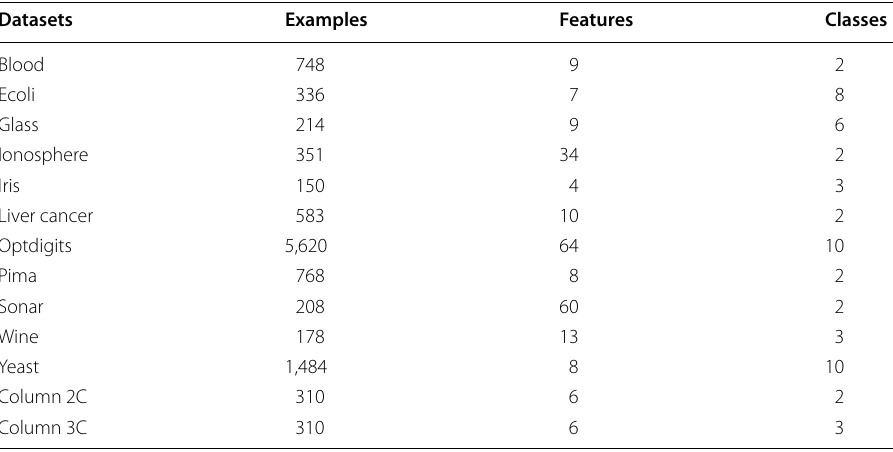
Table 1 Basic information on the numerical datasets